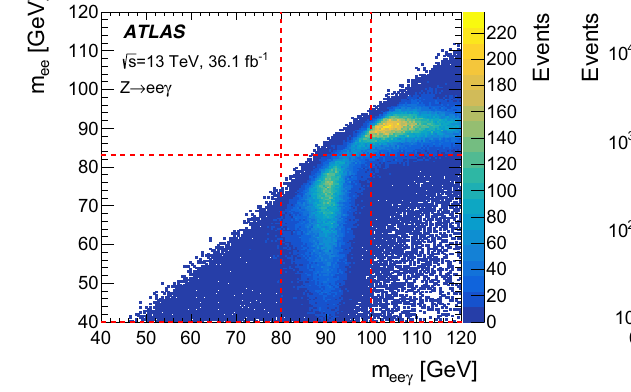
Fig. 4 Left: distribution of m ee γ vs. m ee in events satisfying all Z → ee γ selection criteria except those for m ee γ and m ee ; the hor- izontal and vertical dashed lines show the selections used to isolate radiative decays, 40 < m ee < 83GeV and 80 < m ee γ < 100GeV. Right: distribution of the invariant mass m ee γ for events meeting all selection criteria except the m ee γ selection, and in which the photon